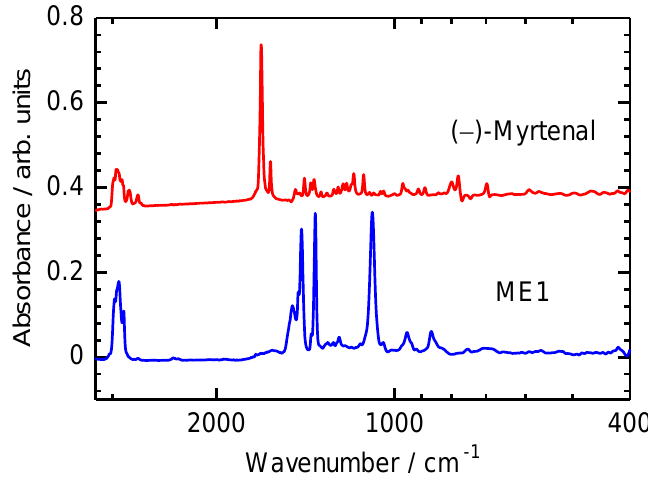
Figure 2. IR spectra of ME1 and (–)-myrtenal.